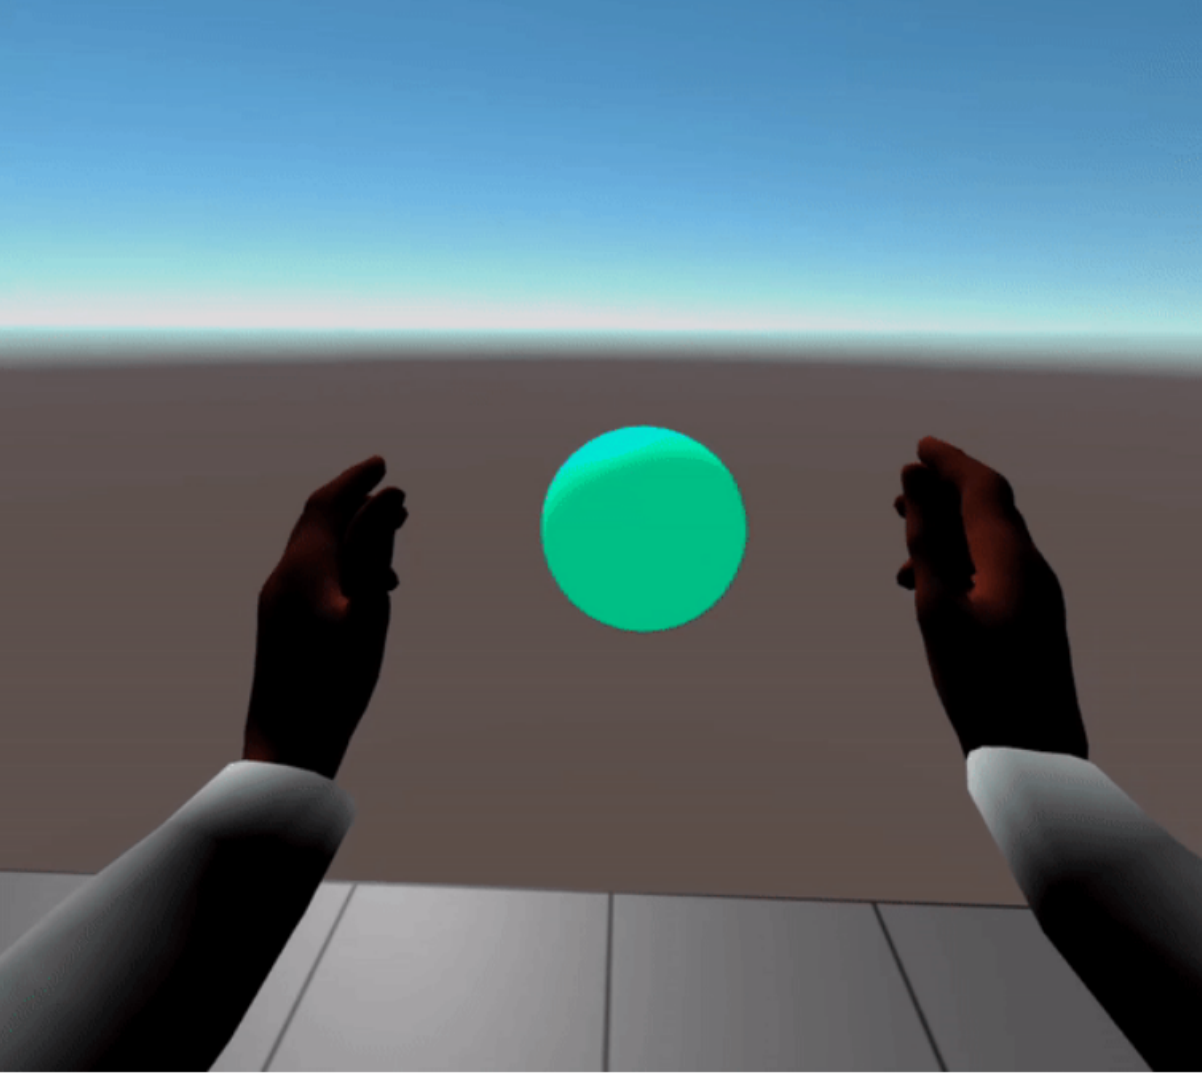
Figure 1. Image representing participant in VELOS MVF with a mono version of their first person